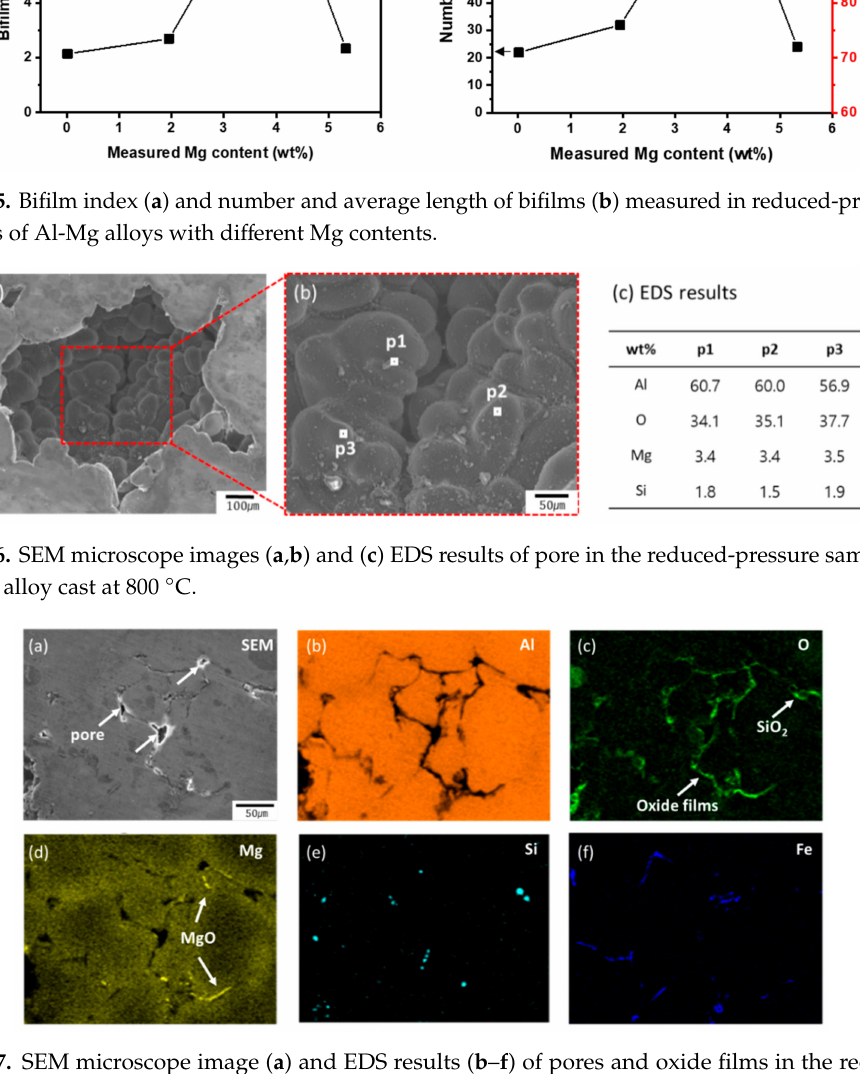
Figure 7. SEM microscope image ( a ) and EDS results ( b – f ) of pores and oxide films in the reduced pressure sample of Al-6Mg alloy cast at 800 ◦